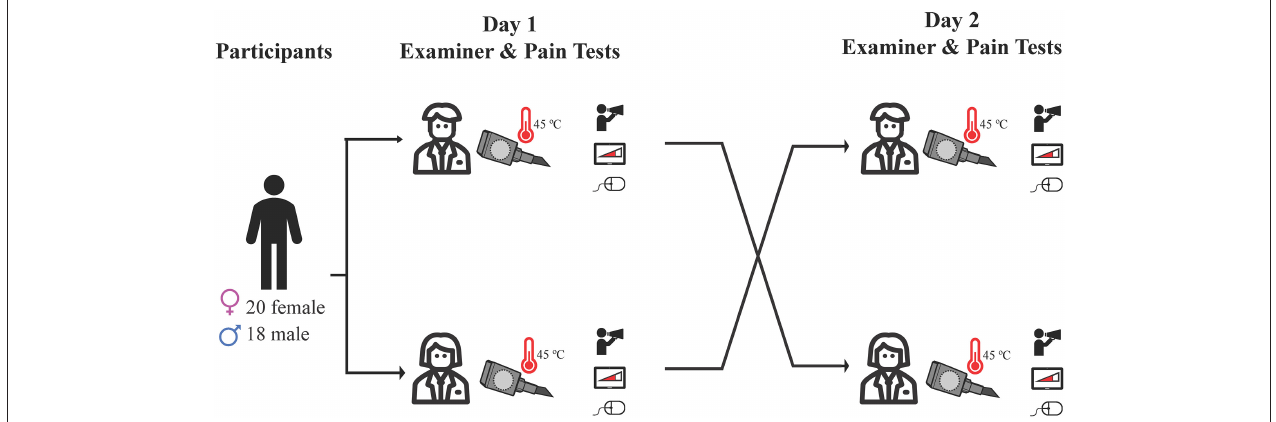
FIGURE 1 | Outline of study protocol. Participants were randomly assigned to a male or female examiner on day 1 in a counterbalanced design, and completed heat pain testing using three different methods: verbal pain rating, computerized visual analog scale, and participant-controlled temperature. Day 2 testing was identical, and was conducted by the opposite gender